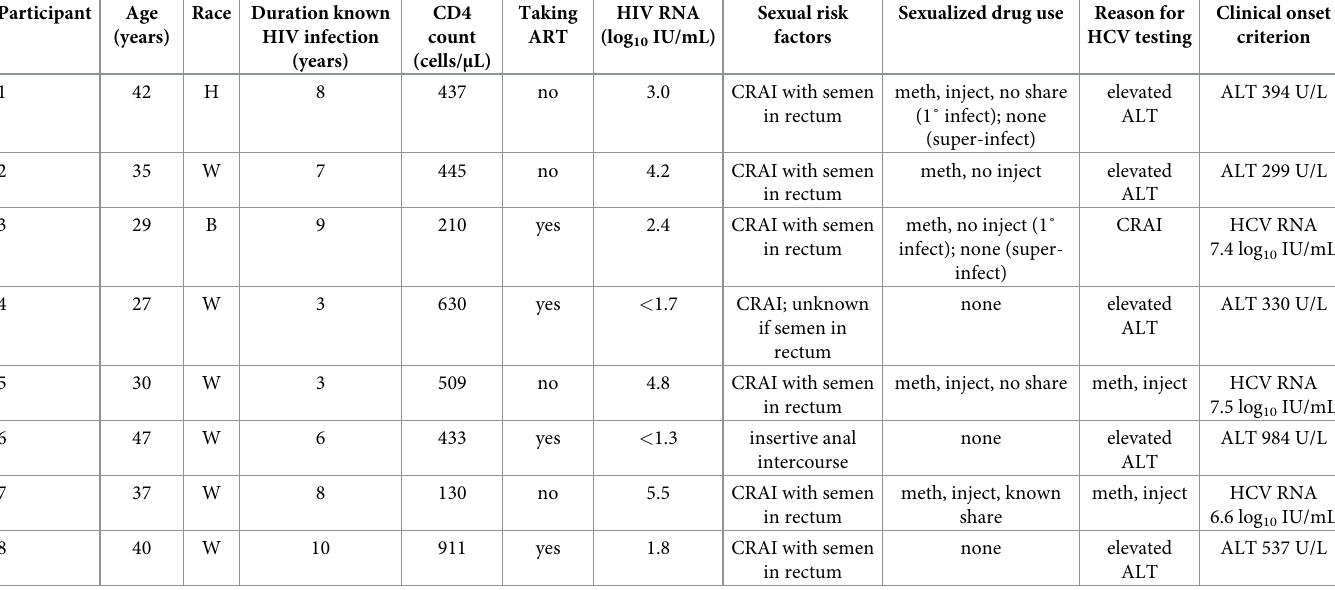
ART, antiretroviral therapy; RNA, ribonucleic acid; HCV, hepatitis C virus; H, Hispanic; W, white; B, black; ALT alanine aminotransferase; U/L, units per liter; IU, international units per liter; mL, milliliter; meth, inject, no share, injection of methamphetamine without sharing of injection equipment; 1˚ infect, primary infection; CRAI, condomless receptive anal intercourse; super-infect,